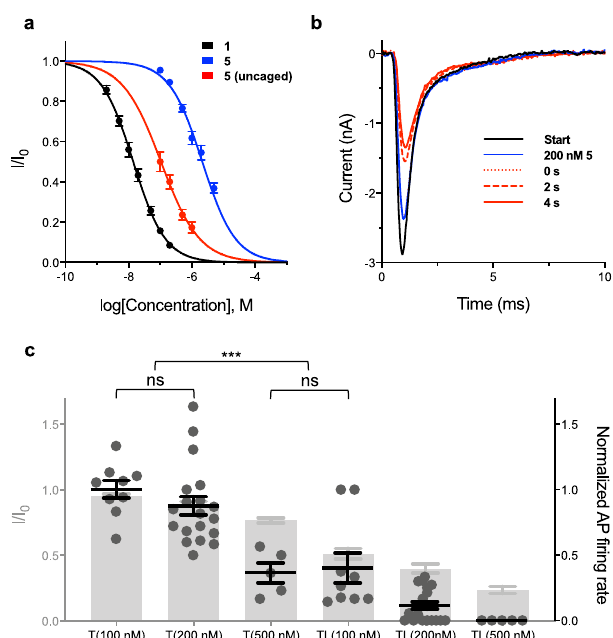
Fig. 3 Uncaging of STX-eac 5 results in fast, concentration-dependent Na V block and inhibition of APs. a Electrophysiological characterization of photocaged STXs against hippocampal neurons DIV 6 – 8. IC 50 s, Hill Coef fi cients: 1 = 14.1±0.8nM, – 0.86±0.04; STX-eac 5 = 2148.4±209.9nM,